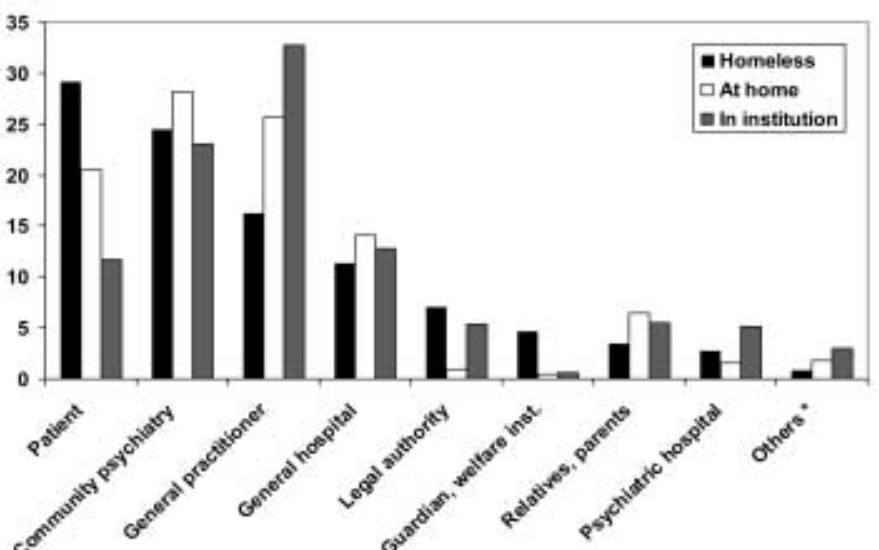
Referral pattern for inpatient treatment in homeless